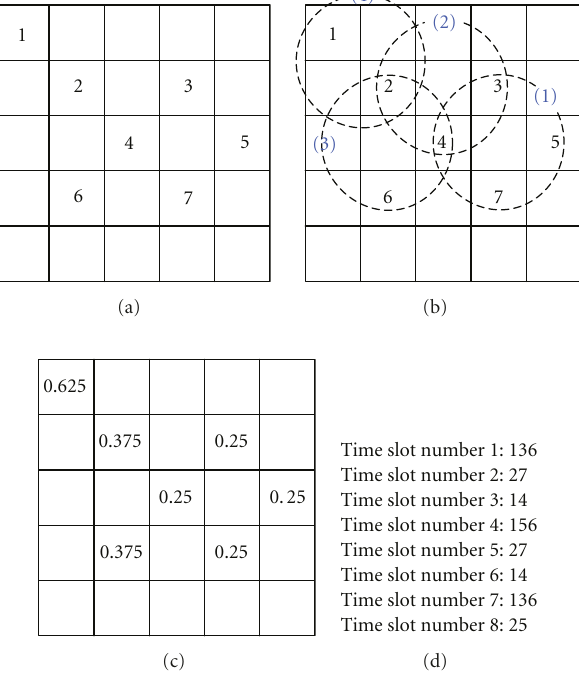
Figure 4: Obtaining the optimal sharing e ffi ciecy on